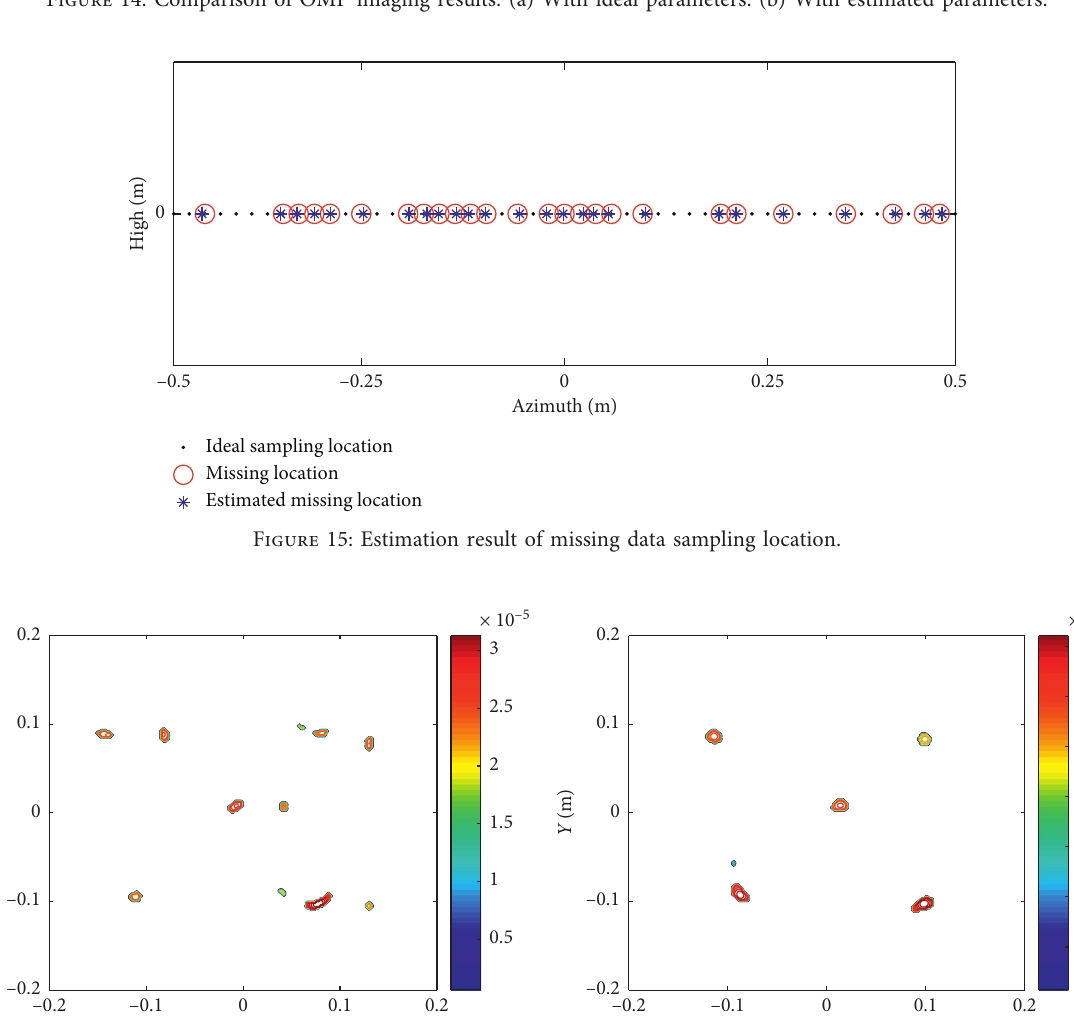
Figure 14: Comparison of OMP imaging results. (a) With ideal parameters. (b) With estimated parameters.